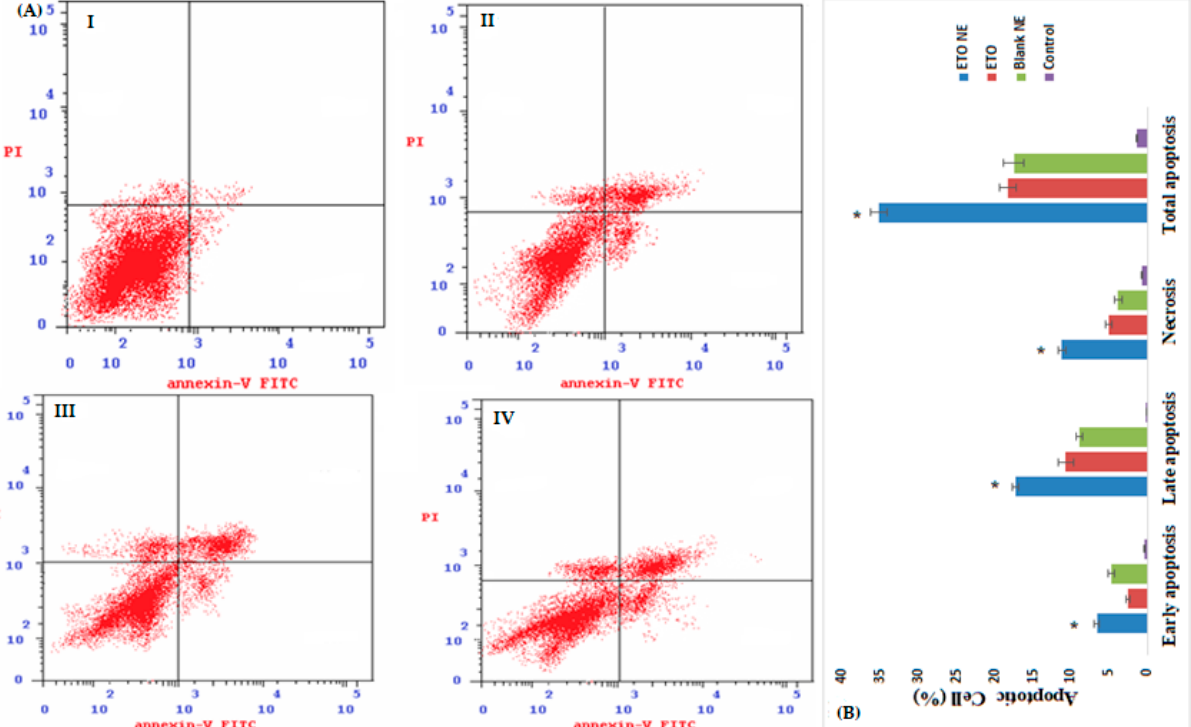
Figure 7. (A ): Apoptotic and necrotic activity of A549 cells treated with ( I ) control (untreated); ( II ) blank NE; ( III ) ETO; ( IV ) ETO-NE in flow cytometry employing PI and Annexin V antibodies. ( B ) Bar graph showing early, late, and total apoptosis in A549 cells as induced by different formulations under investigation. Data are expressed as (mean ± SD, n = 3), * denotes significant difference between ETO NE ( p < 0.05) vs. free ETO, blank NE and control group.